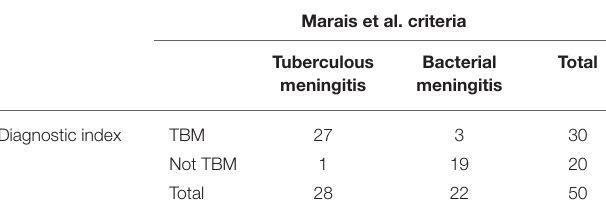
TABLE 6 | Diagnostic index scores by diagnosis.